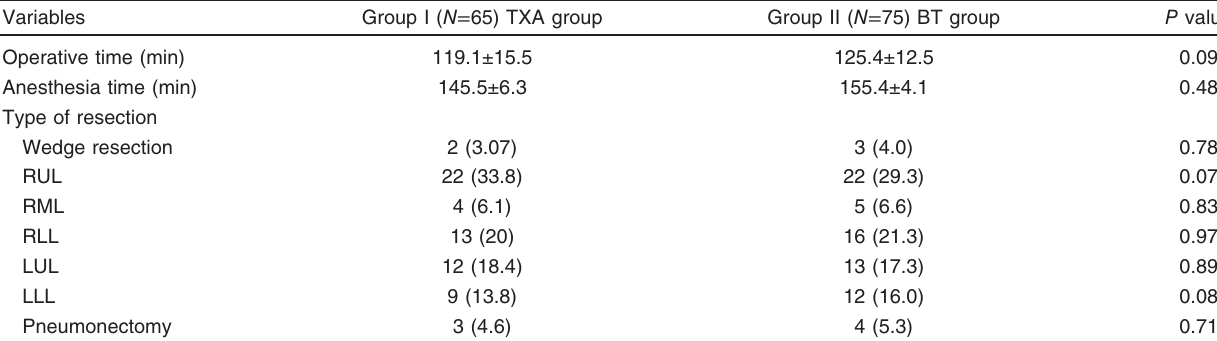
Table 2 Intraoperative characteristics of patients in both groups (total number = 140 patients: group I = 65 and group II = 75) Variables Operative time